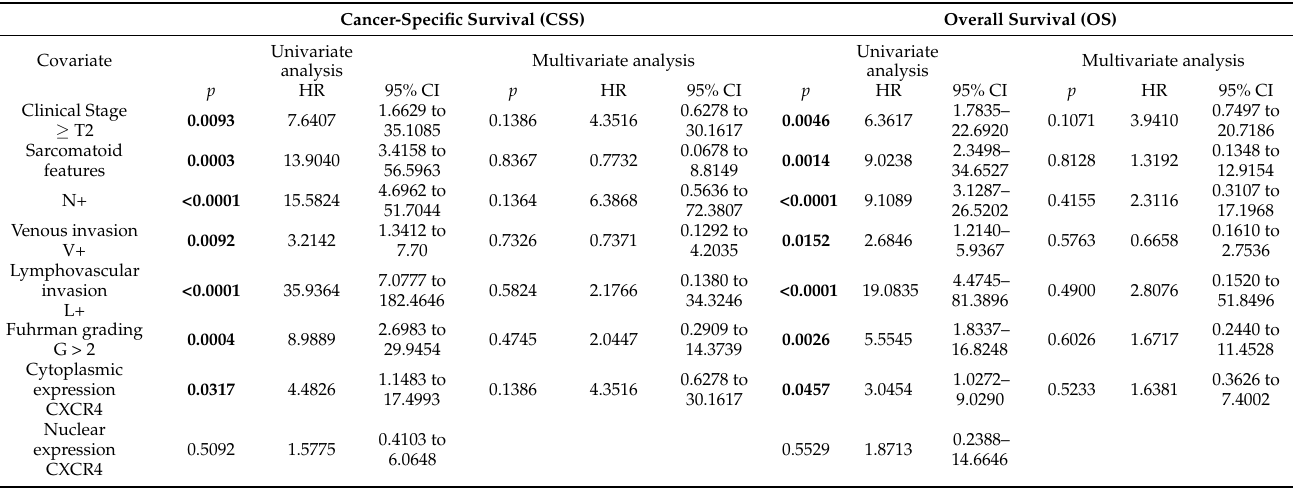
Table 5. Univariate and multivariate Cox regression analysis for cancer-specific survival (CSS) and overall survival (OS). Bold p -values are statistically